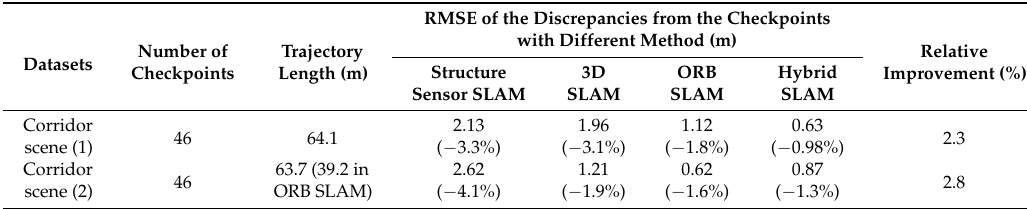
Table 4. Absolute mapping accuracy of corridor scenes using different SLAM method.